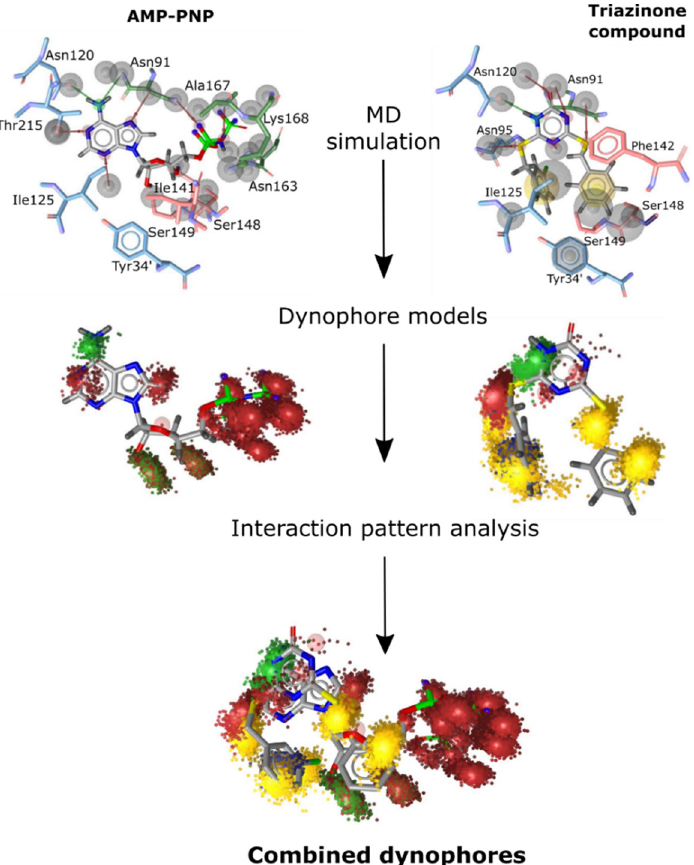
Figure 2. Dynamic Pharmacophores–Dynophores. After performing MD simulations of the AMP-PNP molecule and the catalytic triazinone inhibitor in the human topo II α ATP site, the pharmacophore interactions were calculated over the course of each simulation, resulting in dynophore models. The obtained dynophore models were then analyzed and combined.